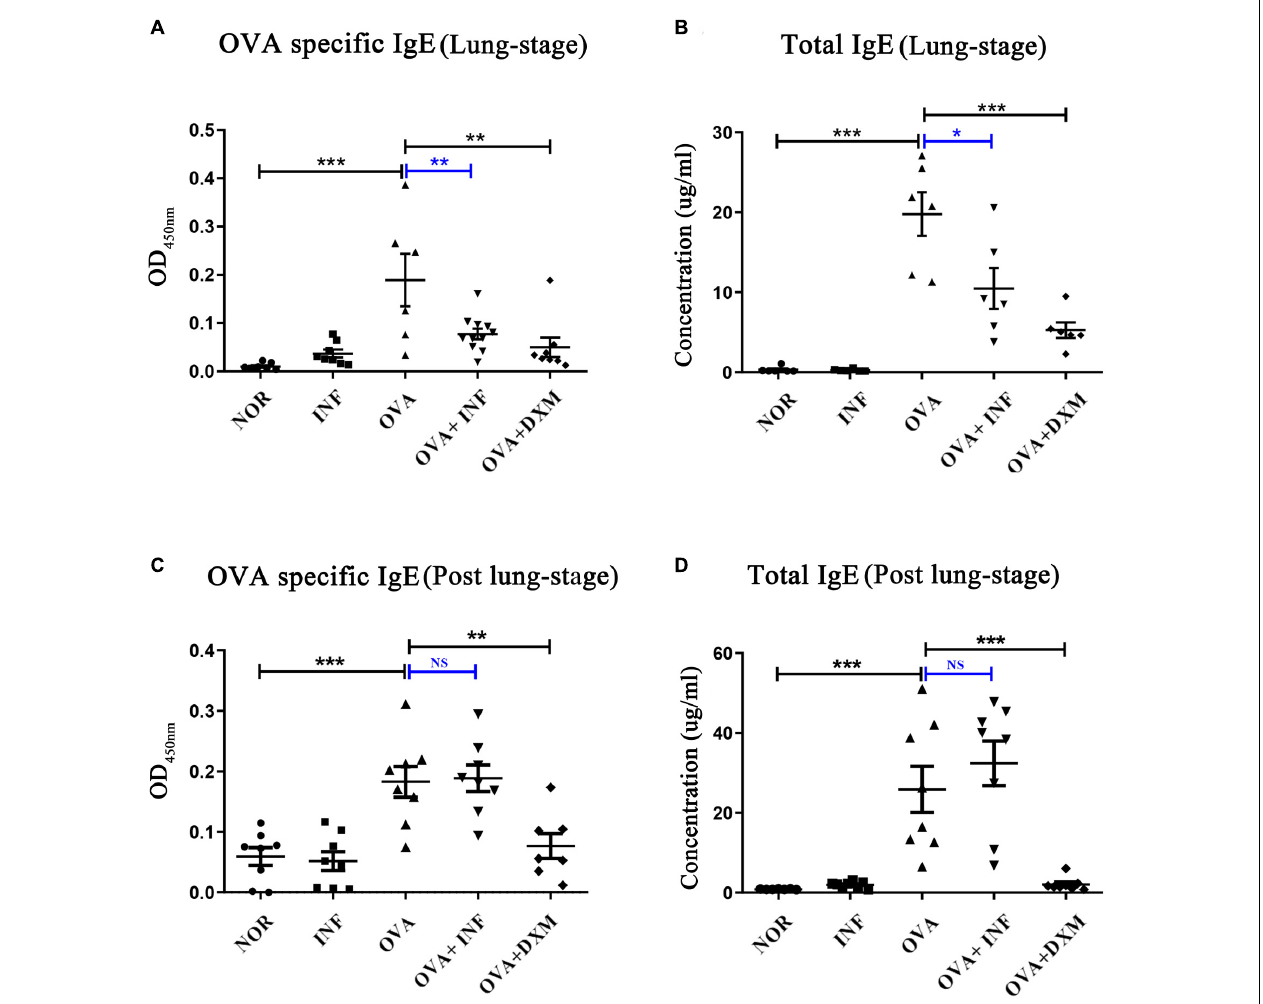
FIGURE 2 | Lung-stage S. japonicum infection suppressed both the total and OVA-specific IgE after OVA challenge, whereas post–lung-stage infection did not. (A,C) OVA-specific IgE in sera were measured by enzyme-linked immunosorbent assay from NOR, INF, OVA, OVA + INF, and OVA + DXM groups ( n = 5 or 6 mice per group, experiment performed twice). (B,D) The concentrations of total IgE in mouse serum were compared among all groups after OVA challenge ( n = 5 or 6 mice per group, experiment performed twice). All data are shown as mean ± SEM. * P < 0.05, ** P < 0.01, *** P < 0.001; NS, not significant by one-way analysis of variance (ANOVA) with Tukey